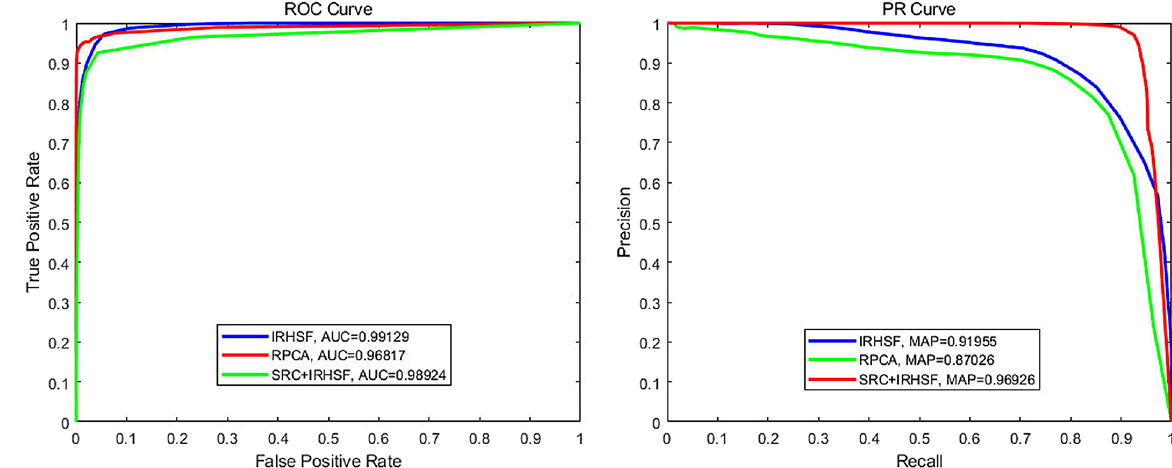
Figure 12. ROC and PR curves of three discussed methods based on the image pair with the big change region.